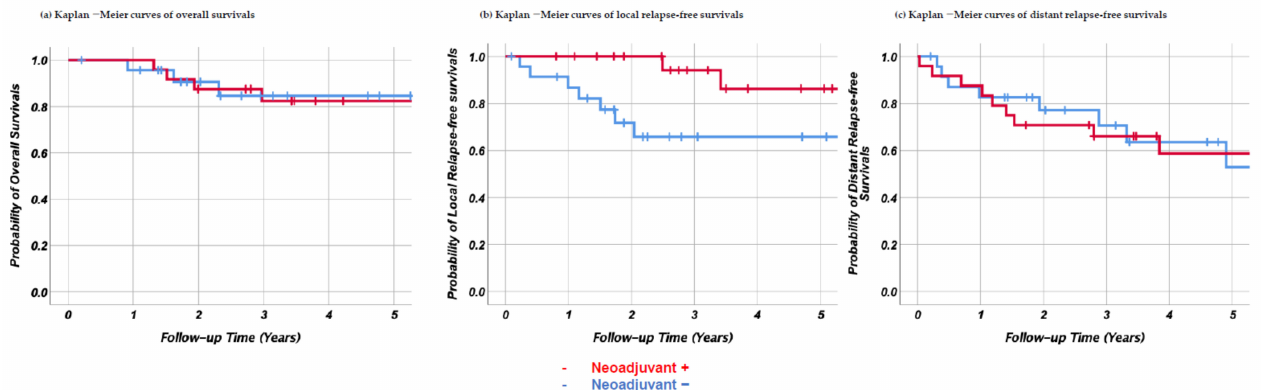
Figure 4. Kaplan–Meier curves comparing patients who underwent neoadjuvant therapy with those who did not, among UPS + MFS subtypes. ( a ) Overall survival, ( b ) local relapse-free survival, and ( c ) distant relapse-free survival. The red and blue lines indicate patients with and without neoadjuvant therapy,